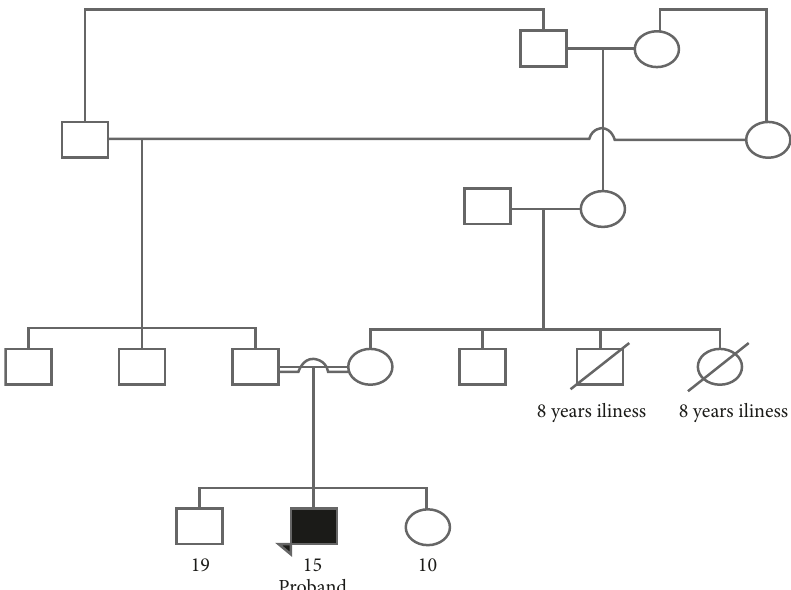
Figure 2: Pedigree of the patient showing consanguinity in the parents (drawn using online tool; progeny genetics) (https://pedigree.